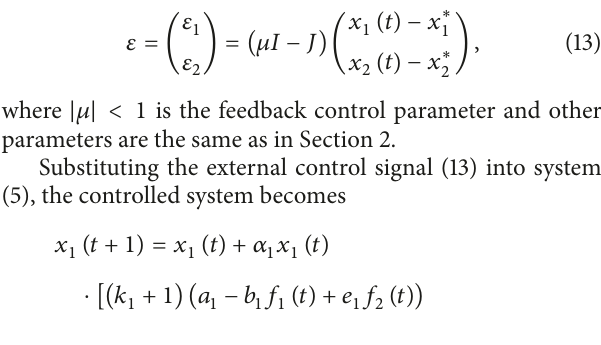
system is in a chaotic state. Figures 13 and 14 show the relationships between inputs and time, which confirm that system (9) has significant sensitivity to initial